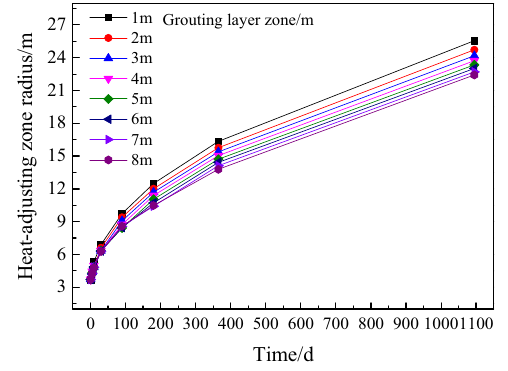
Figure 12: Influence of grouting layer zone on heat - adjusting zone radius.